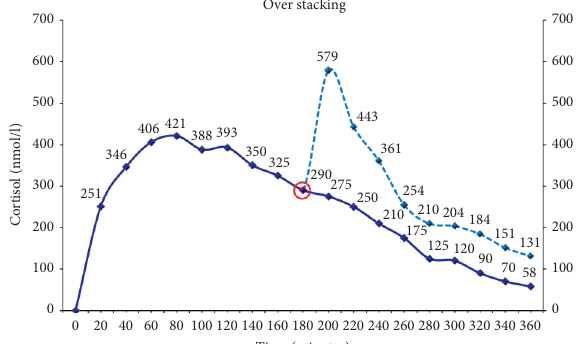
Figure 3: Hydrocortisone stacking in a prepubertal male aged 10 years with salt-wasting congenital adrenal hyperplasia on hydro- cortisone dosing of 12mg/m2/day and a 9-alpha fludrocortisone dose of 100 micrograms per day. A dose of hydrocortisone (7.5mg) is given at time zero (time course depicted by the solid blue line). On a second occasion, a further lower dose (5.0mg) (time course depicted by the dashed blue line) is given 180 minutes; later, the second dose stacks on top of the previous dose (see the circled point) giving a higher cortisol concentration than expected. Samples are drawn at 20-minute intervals Reproduced from Congenital Adrenal Hyperplasia: A Comprehensive Guide, Hindmarsh P and Geertsma K Elsevier, New York